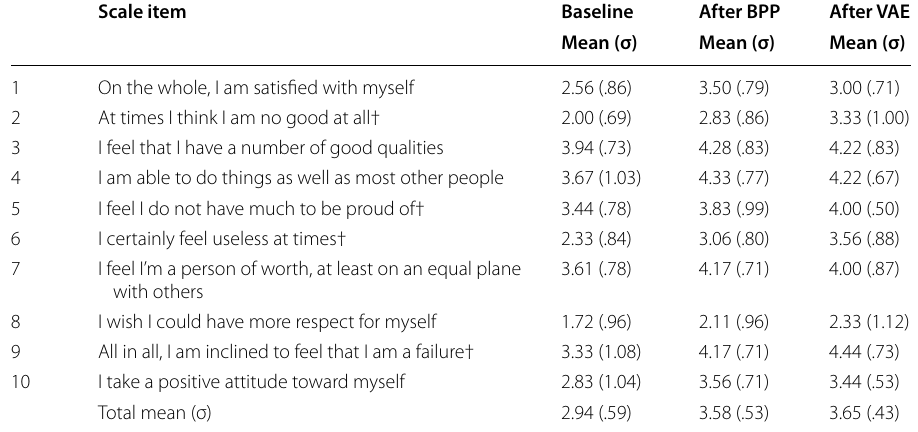
Table 3 Self-esteem scores across the intervention program